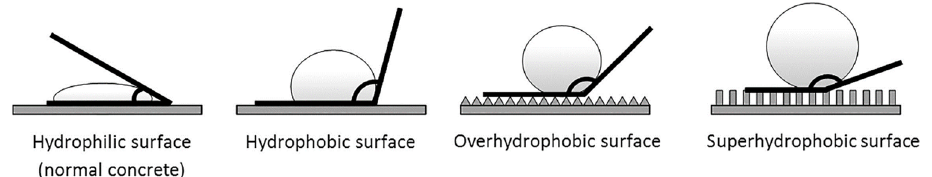
Figure 3. Hydrophilic (0° ≤ h ≤ 90°), hydrophobic (90° < h), very hydrophobic (120° ≤ h < 150°) and superhydrophobic (150° ≤ h ≤ 180°) surfaces, where h is the wetting angle value. Reprinted with permission from [34].